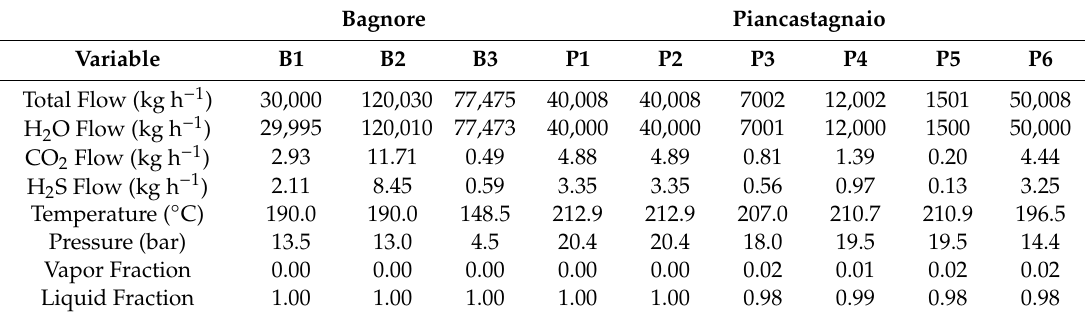
Table 1. Characterization of the waste streams reinjected in the wells network of the geothermal areas. Bagnore